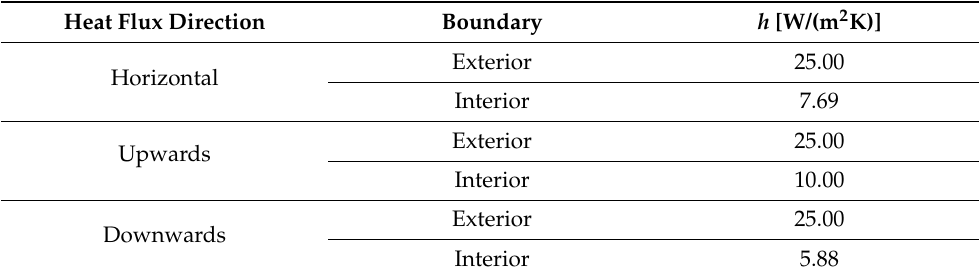
Table 3. Surface heat transfer coefficients [34].